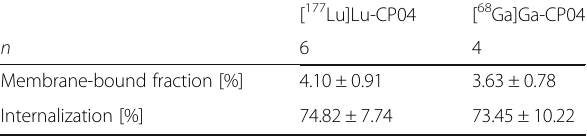
Table 1 Cellular uptake and internalization of radiolabeled CP04 complexes